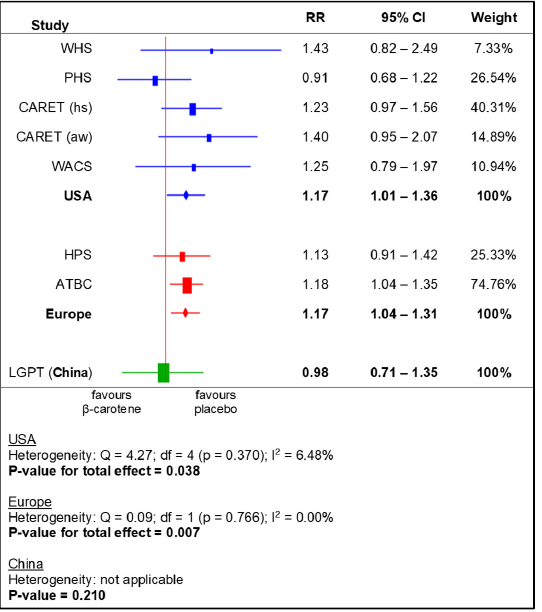
Figure 4. Meta-analysis for subgroups (world regions)—lung cancer incidence depending on beta-